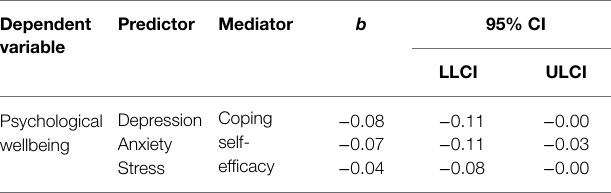
TABLE 8 | Indirect effect of depression, anxiety, and stress on psychological wellbeing, as mediated by coping self-efficacy. Dependent